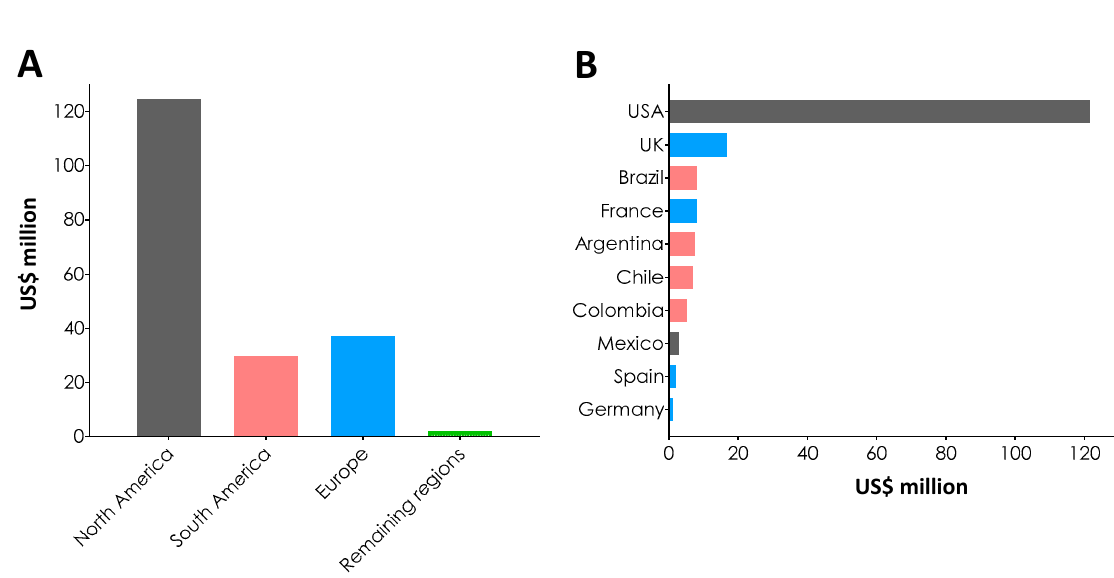
Figure 3. ( A ) Funds for Chagas disease from the main geographic regions. ( B ) Fractioned funds by each country. The colors are correlated with each geographic region in ( B ). The data in ( A ) and ( B ) refer to investments coming from the public sector and philanthropic organizations in each region, thus excluding the private sector, which has headquarters in di ff erent countries. The values are adjusted for 2018 inflation and are expressed in USD in million. Note that the countries are grouped by their geographic regions and not by the origin of the spoken language (like the Latin American countries); in this way, Mexico is found in North America [20]. Table 3. Top 20 funders in Chagas disease [20].